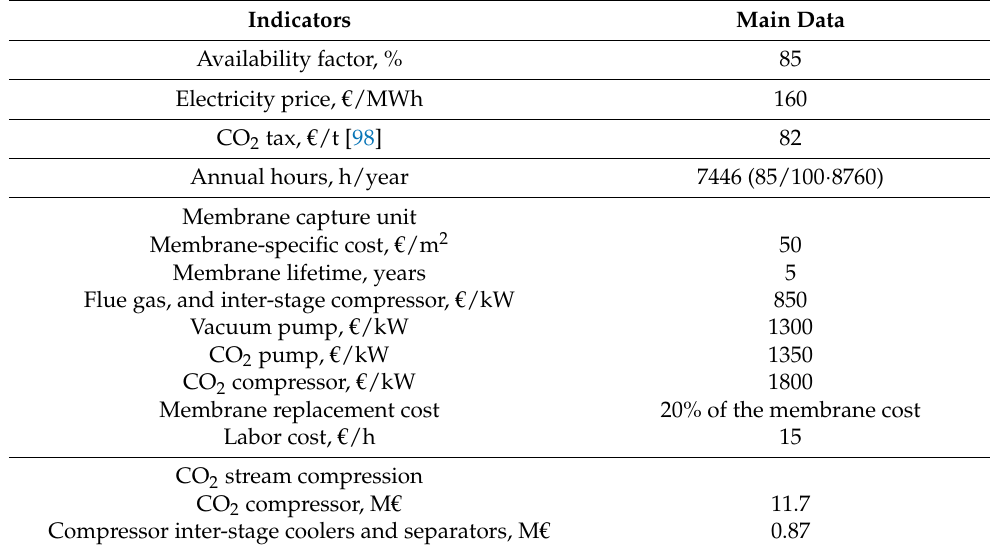
Table 8. Main assumptions concerning the economic